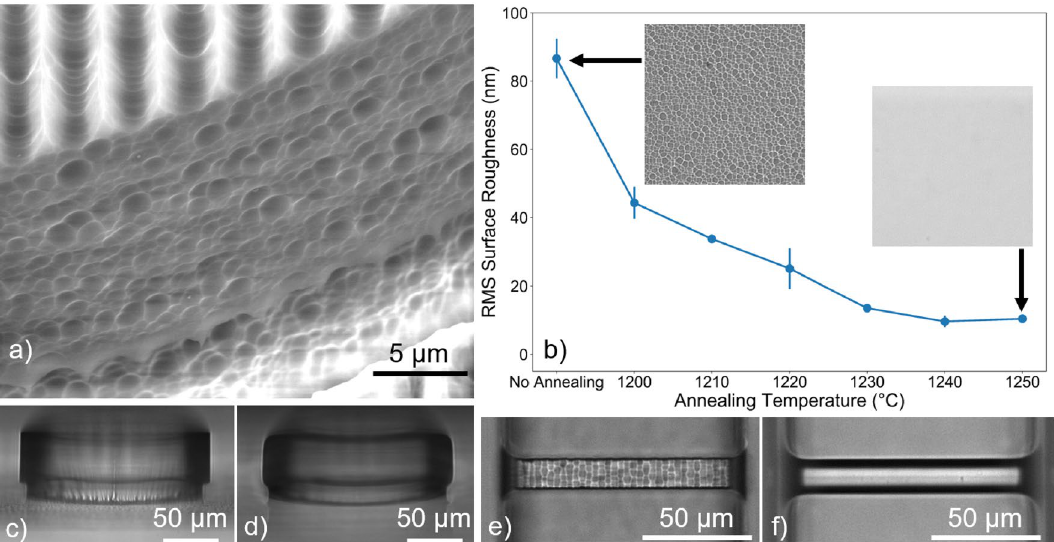
Figure 2. Surface roughness of the microstructures. ( a ) SEM image of a microdisk with radius and height of 75 µm by 50 µm after chemical etching. ( b ) Evolution of the RMS roughness with chemical etching and annealing temperature. The insets show the profile of the microfluidic channel’s surface after chemical etching and after thermal annealing at 1250 °C. ( c , d ) Cross-section image of the same microresonator before and after thermal annealing at 1250 °C, respectively. ( e , f ) Top view image of a 100-µm long suspended waveguide before and after thermal annealing at 1250